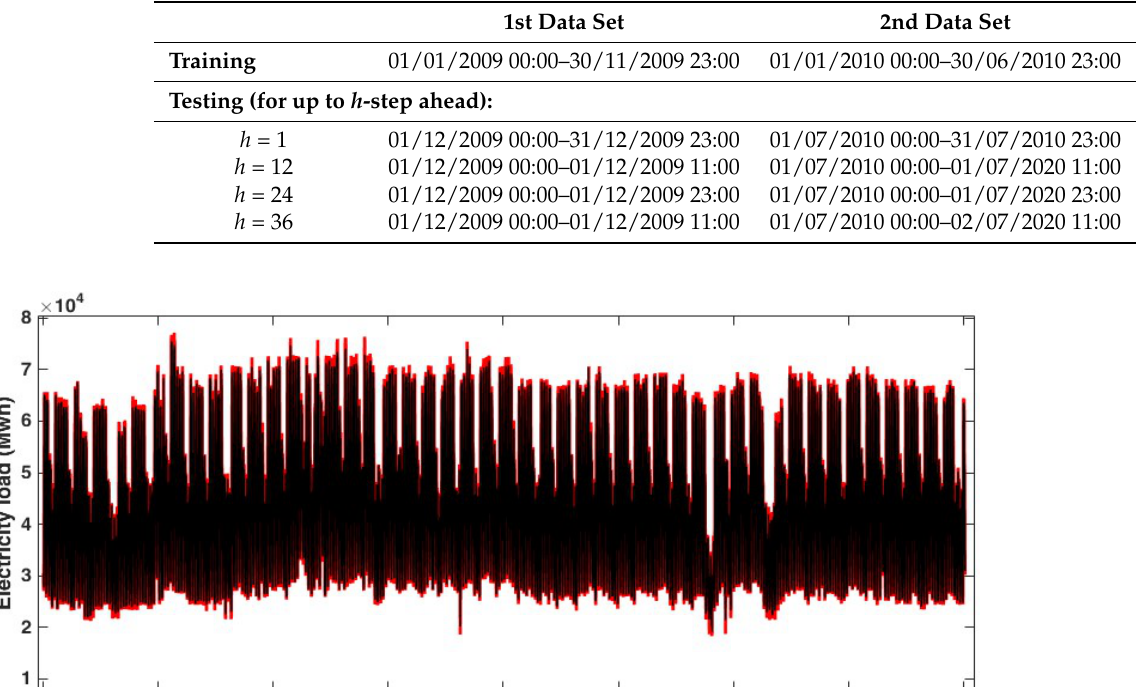
Table 1. Training and testing datasets of hourly load series used in the experimental study. 1st Data Set 2nd Data Set